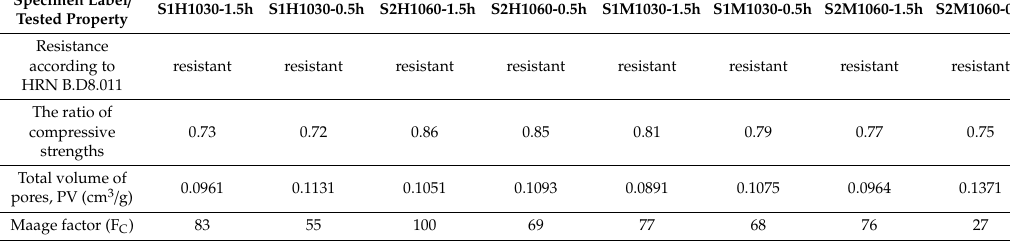
Figure 9. Compressive strengths of the bricks before and after freeze–thaw cycles. Table 6. Results of testing–assessment of brick resistance according to both direct and indirect methods, total volume of pores and Maage factor.